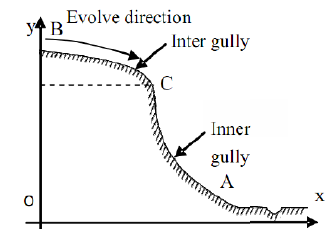
Figure 1. Illustration of loess shoulder line profile(Yan, Tang et al. 2014) Therefore, the shoulder line should be extracted to separate surface into positive terrain and negative terrain and removing “noise” points respectively. Many methods of shoulder line extraction have been proposed based on DEM, which can be referenced (Lu, Qian et al. 1998, Xiao and Tang 2007,